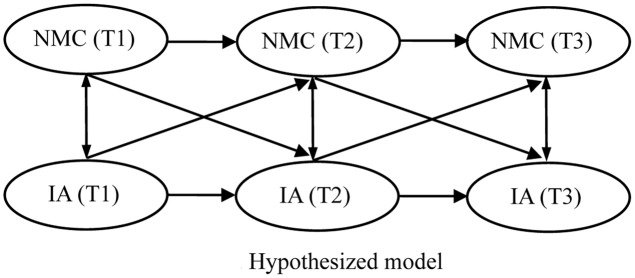
Hypothesized model.